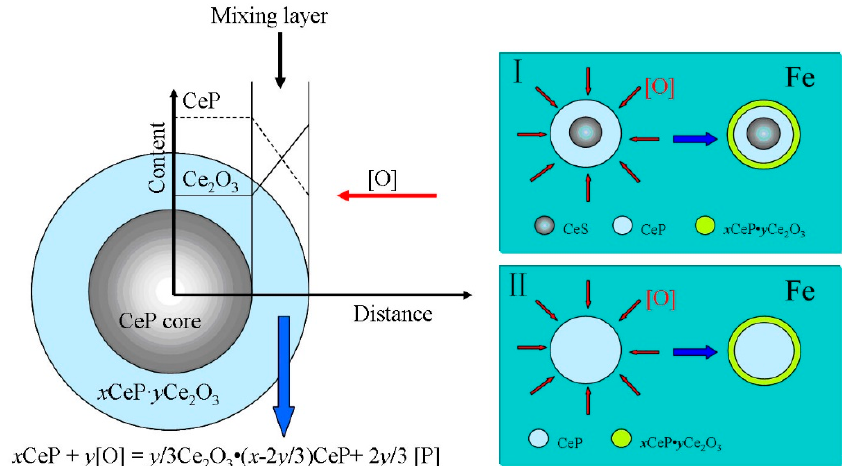
Figure 12. Mechanism diagram of the oxidization reaction of cerium inclusions in steel.